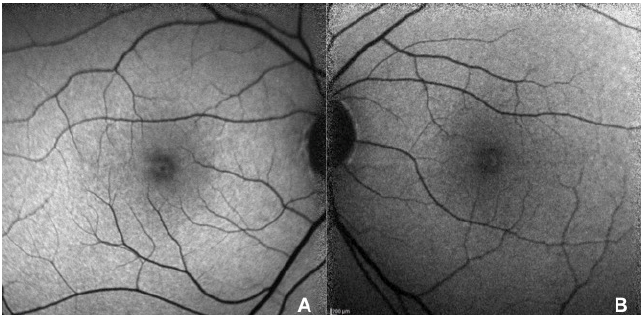
Figure 2: FAF imaging was normal; A) OD, B) OS